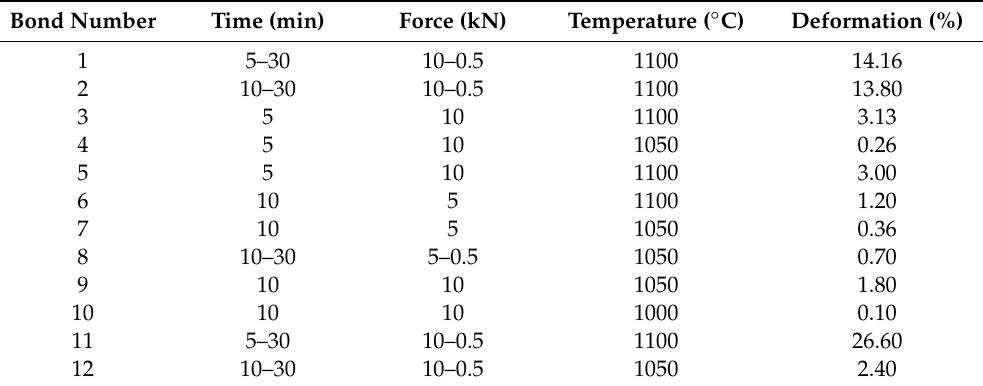
Figure 1. Powder Interlayer Bonding (PIB) setup. Table 1. Bonding parameters and resultant upset for each